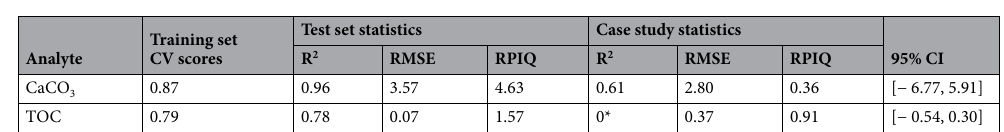
Table 1. Scores for the optimal models of calcium carbonate (CaCO 3 ) and total organic carbon (TOC). Cross- validation (CV) score stands for the learning performance in the training set, which is the mean of R 2 during to inter-quartile distance (RPIQ) estimate the performance and uncertainty of the optimal models in the test set and case study. CI and RMSE both have wt% as the unit. *Negative R 2 is considered as 0.